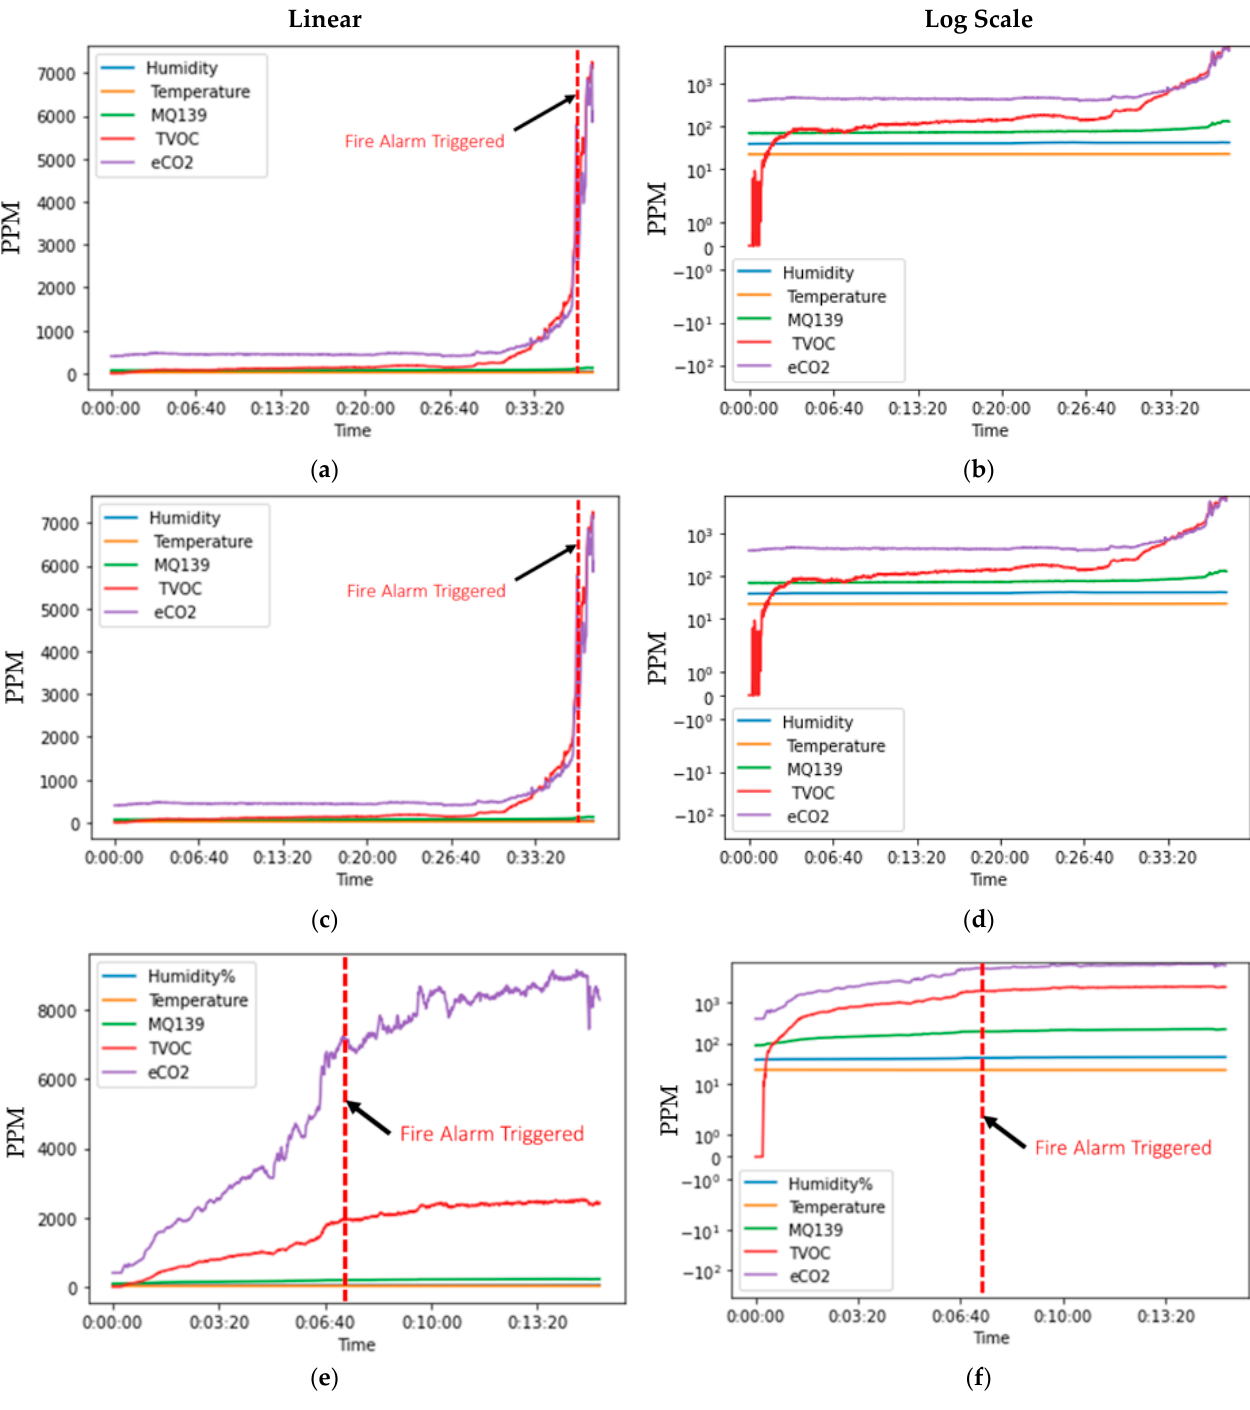
Figure 4. Linear and log scale measurements: ( a , b ) Electrical/Cloth fire; ( c , d ) Charcoal/Cardboards fire; ( e , f ) Charcoal/Clothing fire.